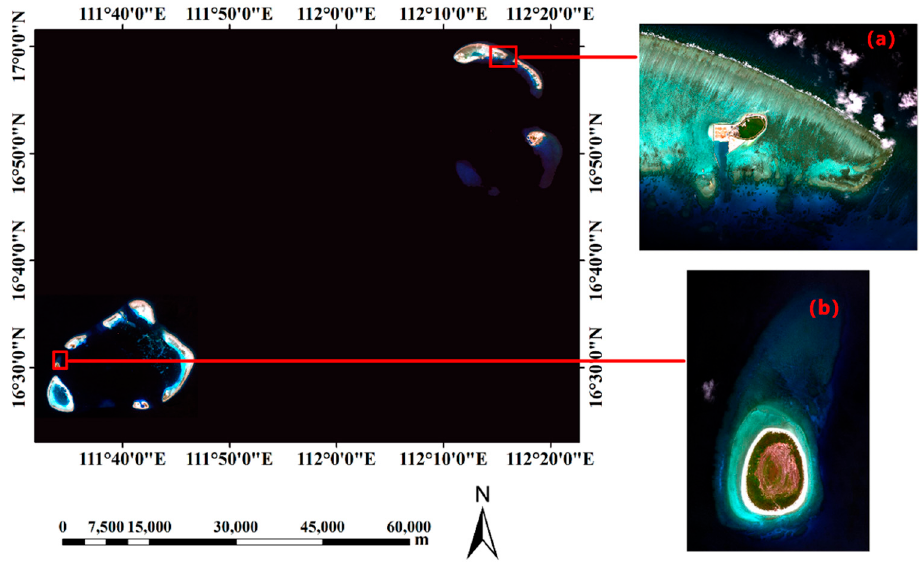
Figure 3. Geographic locations of the experimental regions—Zhaoshu Island ( a ) and Ganquan Island ( b ).